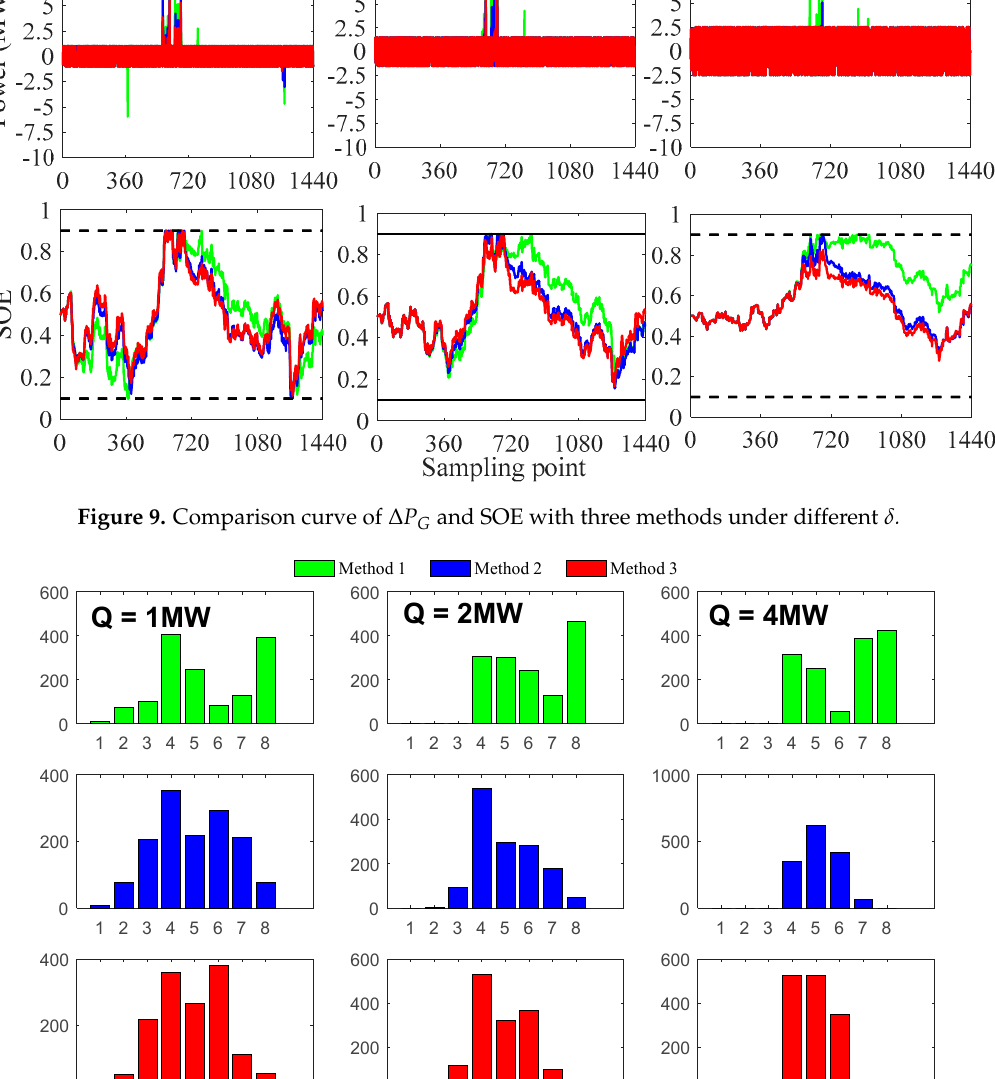
Figure 10. Frequency distribution histograms of different energy storage SOE intervals under different Q during a typical day.